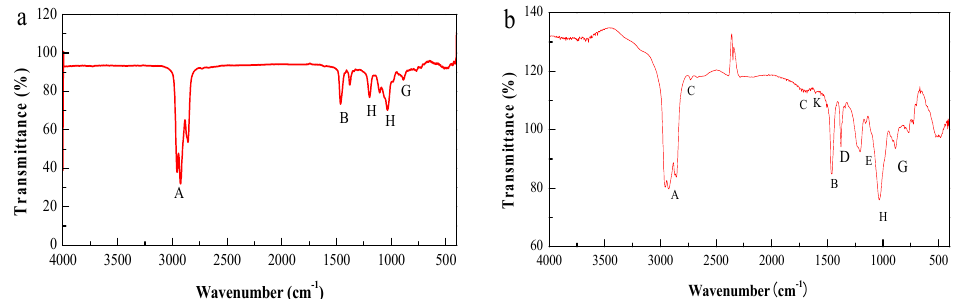
Figure 4. The FTIR spectroscopy for organic phase: ( a ) without addition of organic acid and strong alkali, and ( b ) with addition of organic acid and alkali. A, stretching vibration of C-H; B, bending vibration of C-H; C, P-O-H bond vibrations of hydrogen bond association; D, coupled vibration of P=O bond; E stretching vibration of C-; G, stretching vibration of P-O; H, stretching vibration of P-O-C; J, O-H vibration; K, vibration of organic acid.